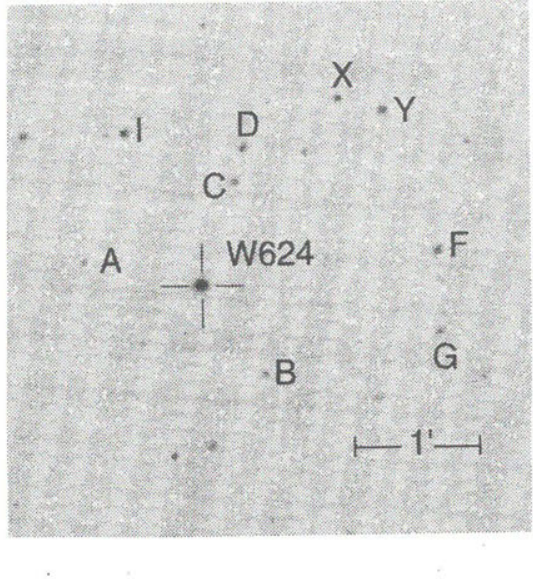
Fig. 2, Finding chart for G 16-25 = W